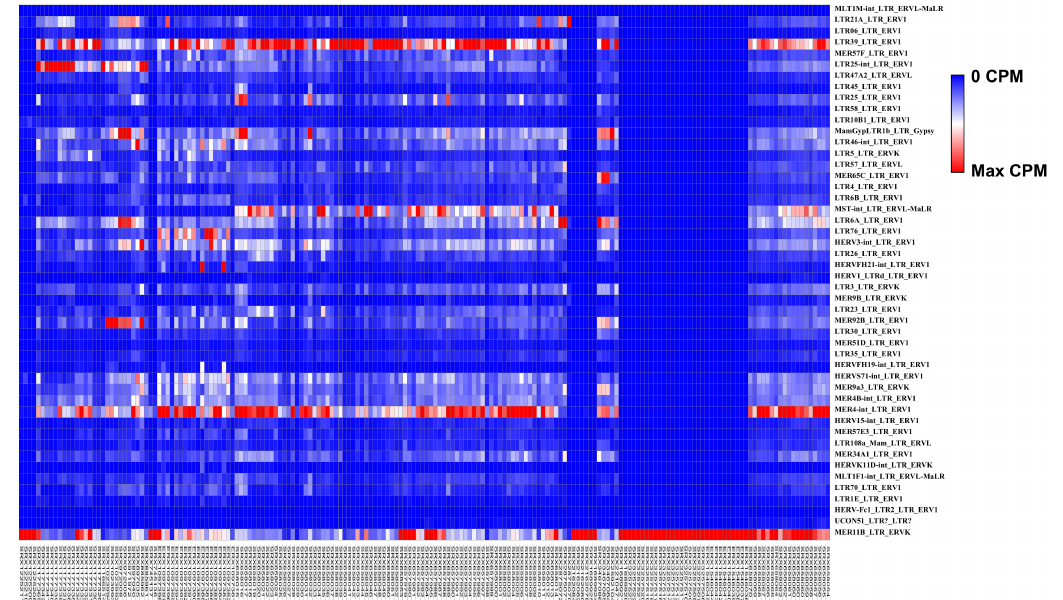
Figure 1. The heatmap of differentially expressed long terminal repeat (LTR) elements in glioblastoma multiforme (GBM) compared to normal brain samples. Each row represents the expression of an LTR element, while each column corresponds to an individual sample. GBM samples are highlighted in pink, and normal brain samples are in green. The color represents the expression level of LTR elements as measured by counts per million (CPM) for each sample, ranging from the highest (red) to the lowest (blue) level.